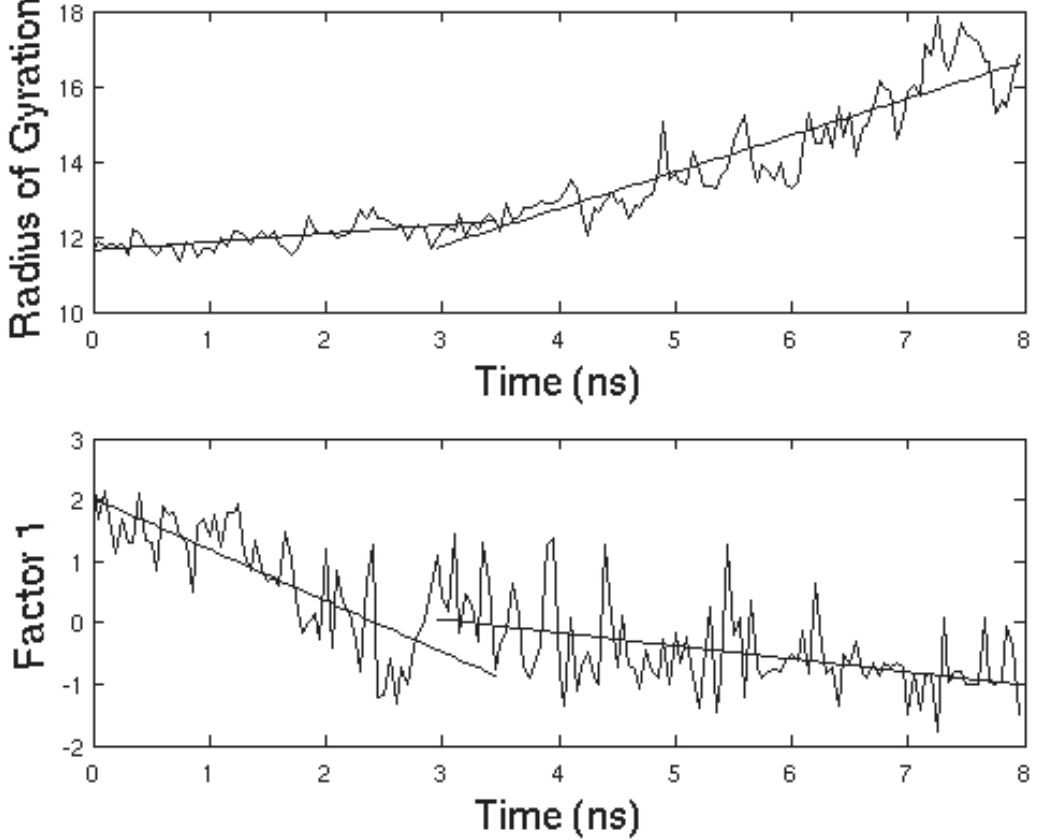
Figure 4. Variation of the Radius of Gyration (RoG) and the first factor obtained from PCA of the RQA quantitative descriptors REC, DET and ENT over time. Top-panel: Variation of RoG with time. Bottom-panel: Variation of Factor-1 with time. In both plots, there are two clearly identified regimes with a marked difference in slope aroud 3 ns indicating a possible location of the TS before this point.